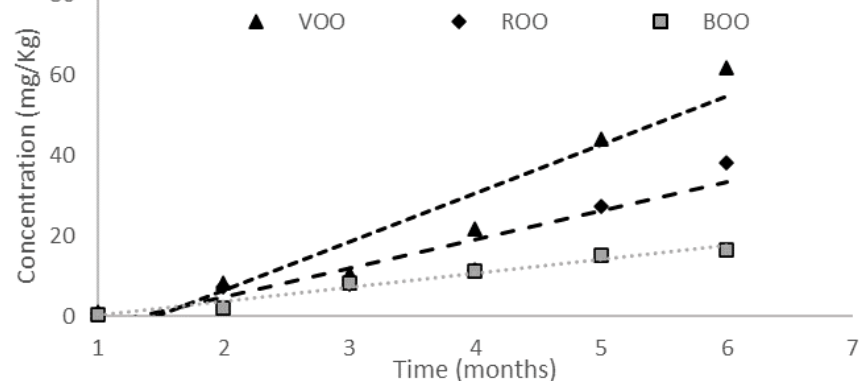
Figure 4. Concentration (mg/Kg) of butanoic acid during the storage in the three samples.